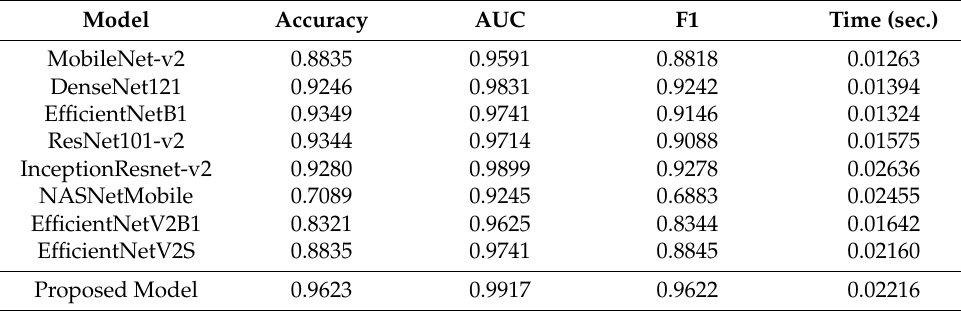
Table 10. Performance metrics of ensemble models with 3-class dataset.